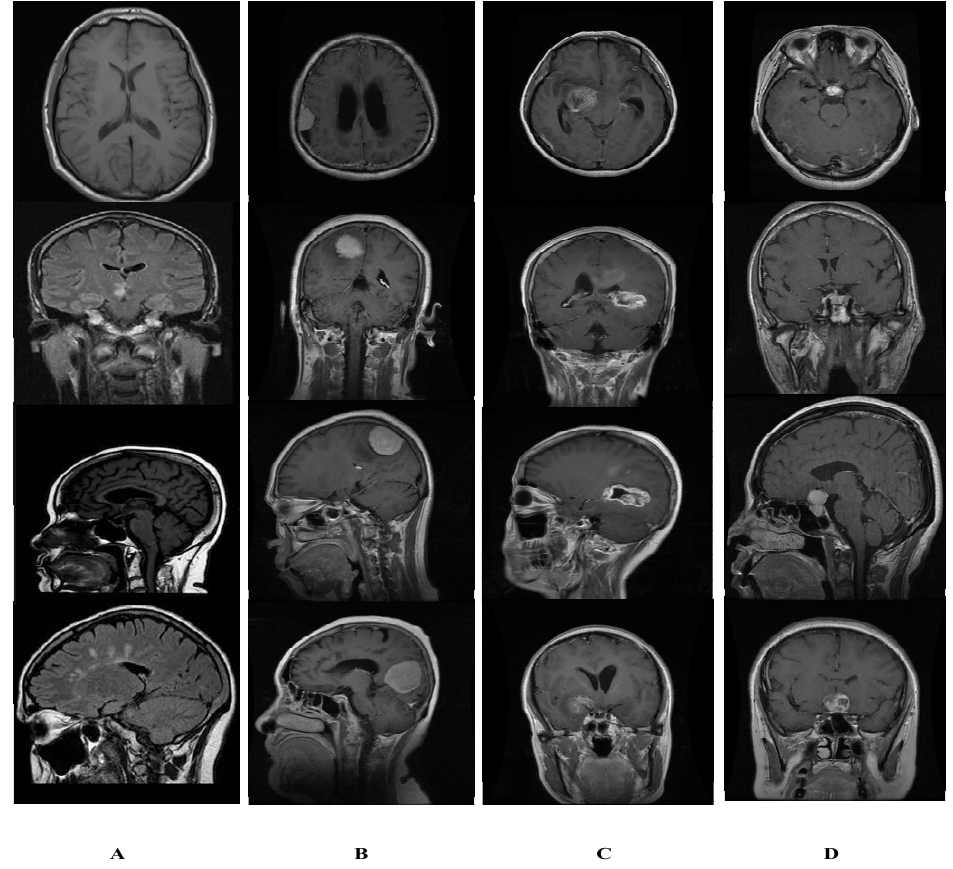
Figure 5. Sample image from dataset of normal and tumor images. ( A ) Normal. ( B ) Glioma. ( C ) Meningioma. ( D ) Pituitary.